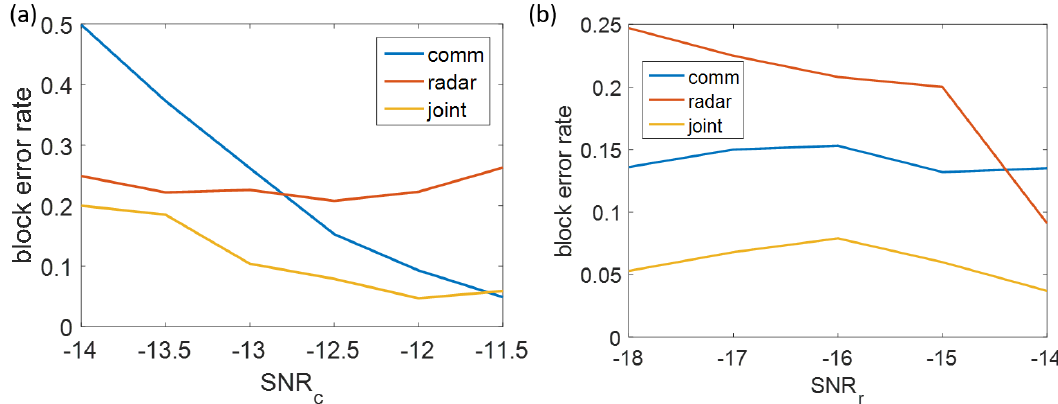
Figure 10. Robustness of the joint diagnosis algorithm: ( a ) bock error rate with joint and single diagnosis under different SNR c ; and ( b ) block error rate with joint and single diagnosis under different SNR rm